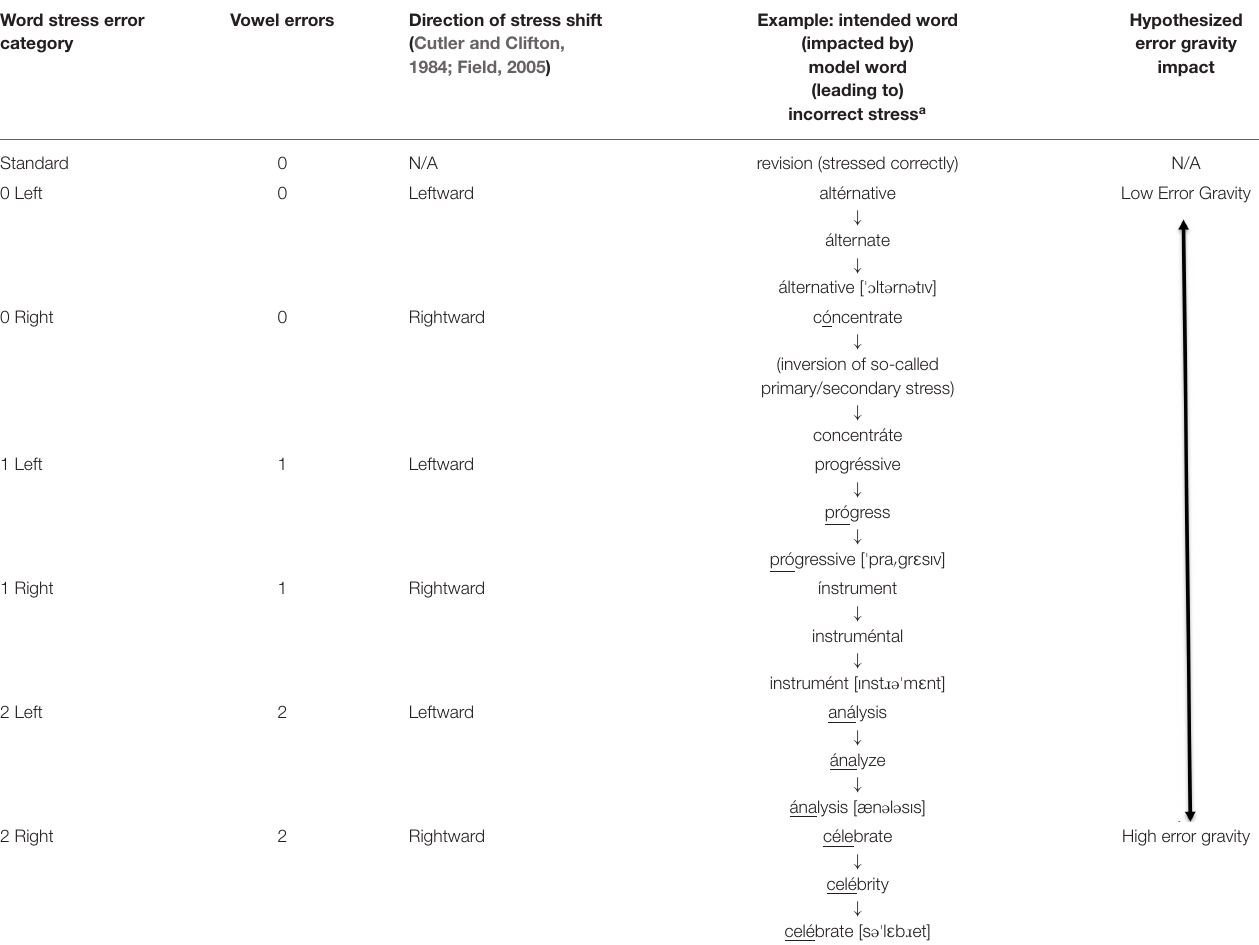
TABLE 1 | A hypothesized English Word Stress Error Gravity